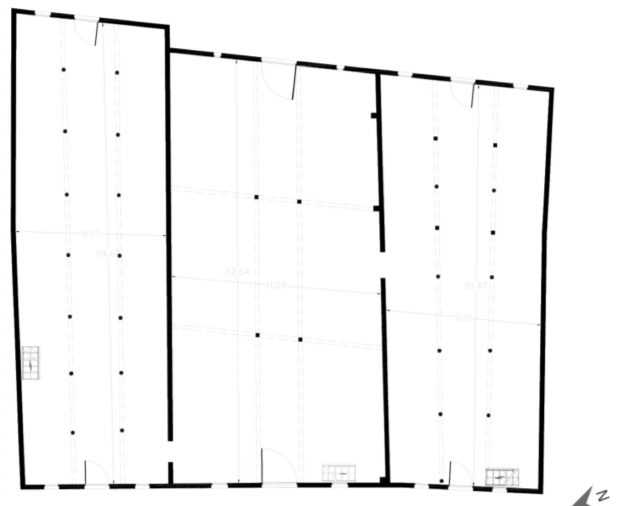
Figure 6. Plan of the 3rd floor of the case-study building, with the position of the structural elements.